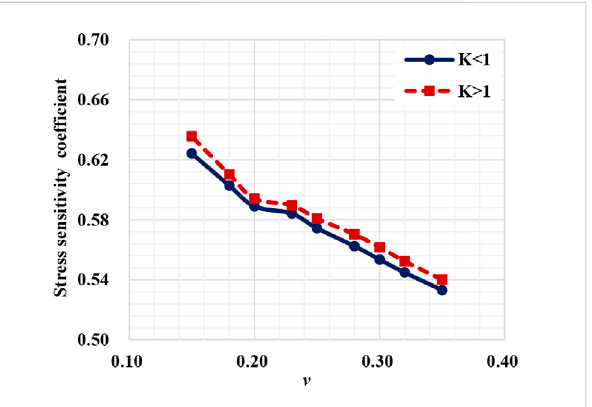
FIGURE 13 Variation of stress sensitivity coef fi cient against Poisson ’ s